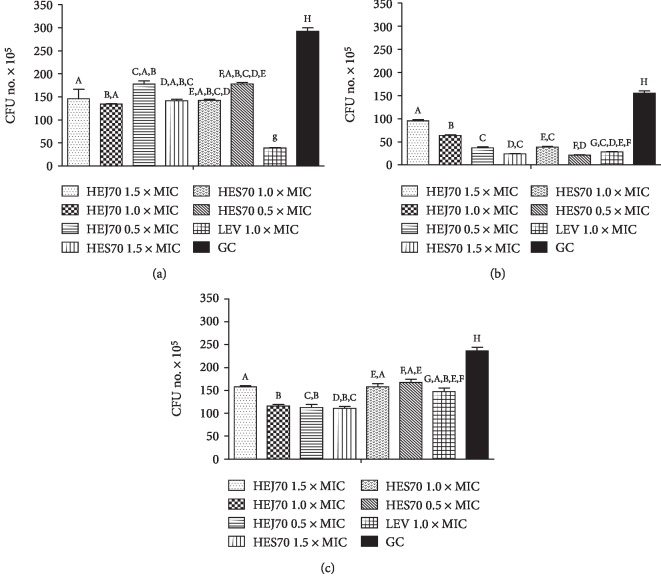
Results of the bacterial cell viability assay after exposure to hydroethanolic extract 70% from Kalanchoe brasiliensis fresh leaves collected in January (HEJ70) and September (HES70) and levofloxacin (LEV) against (a) Salmonella Choleraesuis (ATCC® 10708), (b) Salmonella Typhimurium (ATCC® 13311), and (c) Salmonella spp. 1507708. CFU: colony forming unit. Results were expressed in mean ± S.E.M. (n = 3). Equal letters in the bars mean no difference (p < 0.05) after variance analysis followed by Tukey's test.